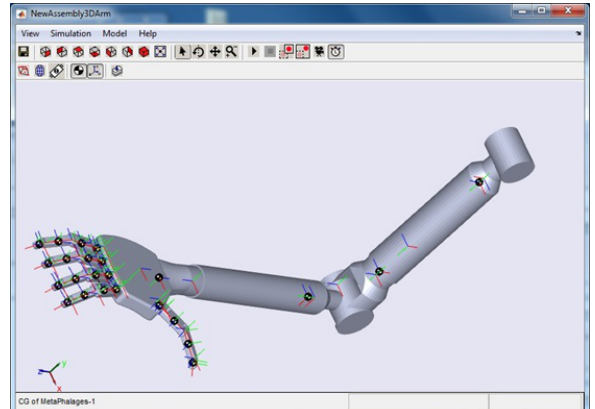
Figure 8: 3D solid work arm design.